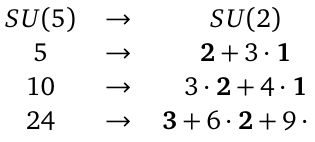
Table 7: Embedding of representations SU ( 2 )